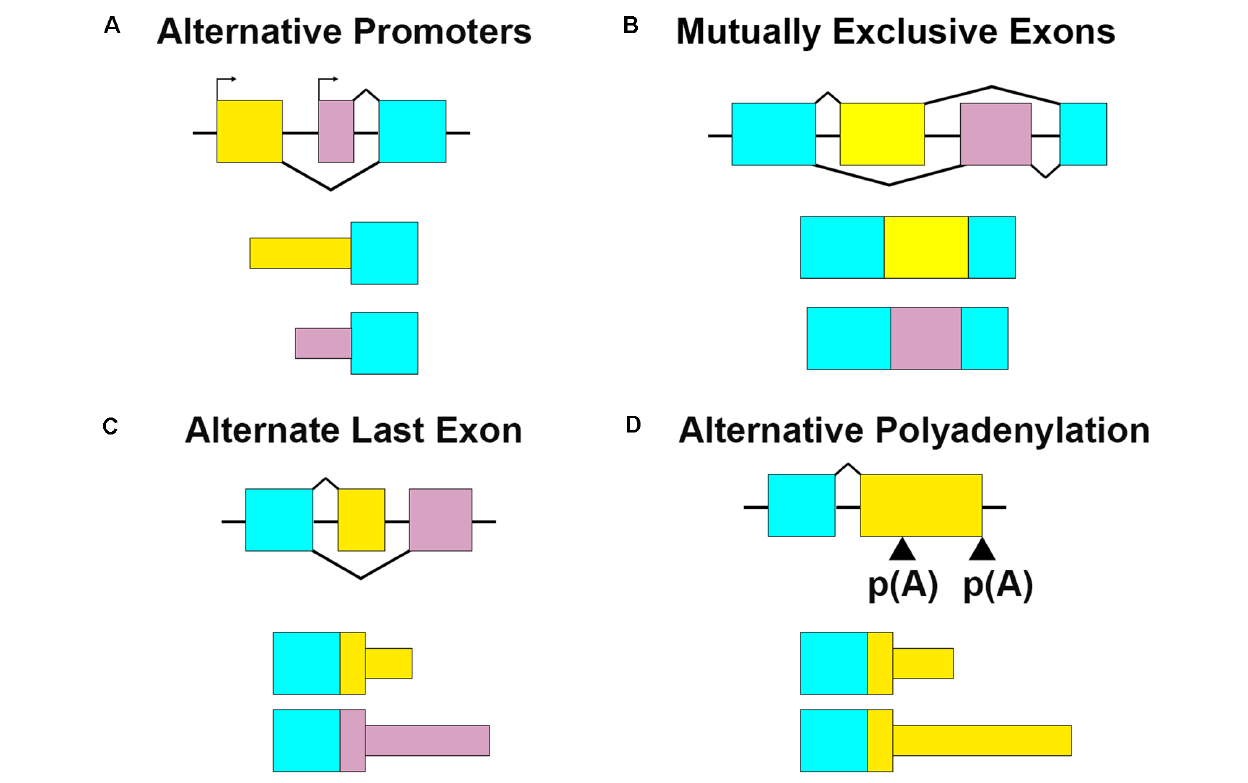
FIGURE 1 | Multiple RNA processing mechanisms contribute to mRNA sequence variation. (A) Alternative promoters change the 5 (cid:48) ends of transcripts by initiating transcription from different start sites. For Bdnf , the alternate promoter determines its dendritic localization. (B) Mutually exclusive exons retain one exon or the other. Gria2 uses this mechanism in combination with RNA editing to modify RNA localization and channel characteristics. (C) Alternate last exons retain one or the other mutually exclusive terminal exons. Cdc42 uses two alternate last exons to vary the terminal coding and 3 (cid:48) UTR sequences, which affect transcript localization and protein properties. (D) Alternative polyadenylation (APA) terminates transcription at multiple places within the same last exon. Also termed tandem 3 (cid:48) UTR, this results in a shortened or elongated 3 (cid:48) UTR. Camk2a harbors multiple 3 (cid:48) UTR lengths through this process, which modifies its posttranscriptional regulatory